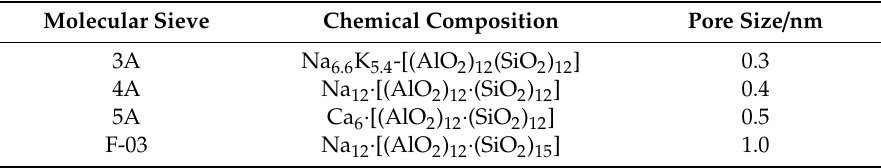
Table 1. Chemical composition and pore size of molecular